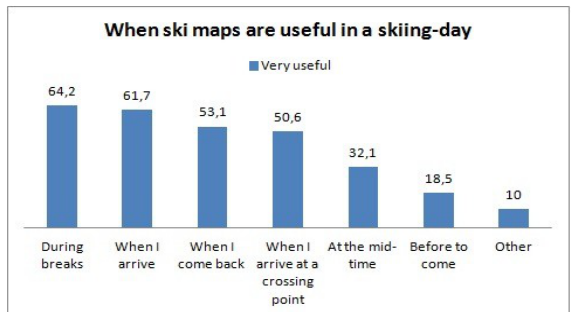
Figure 12 Percent of response “Very useful” ski map in different moments of a